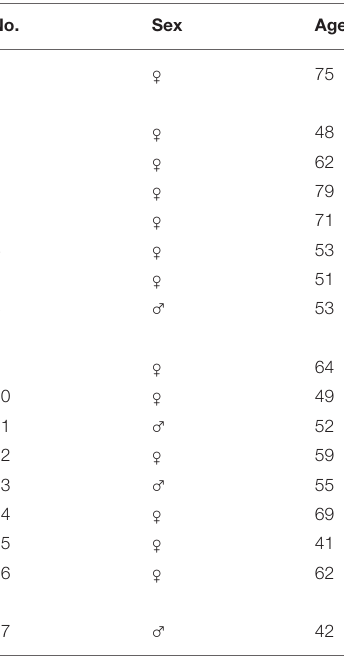
TABLE 2 | Complications of aneurysms treated with LEO